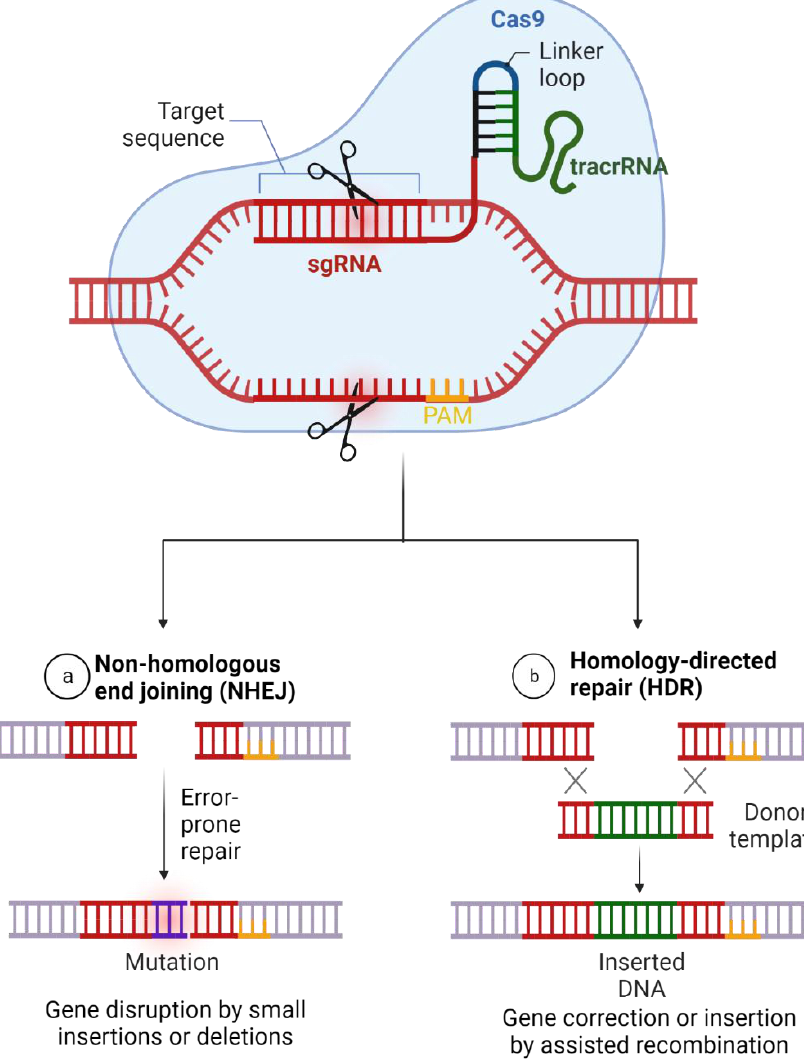
Figure 2. Gene Editing Using CRISPR/Cas system. (Adapted from Ref. [61] with free permission. Created with BioRender.com accessed on 20 September 2022).